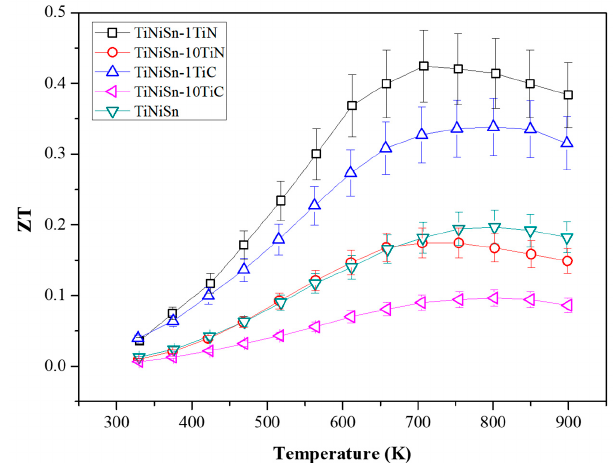
Figure 5. Temperature-dependent figure of merit ZT for TiNiSn, TiNiSn-1TiN, TiNiSn-10TiN, TiNiSn-1TiC, and TiNiSn-10TiC.